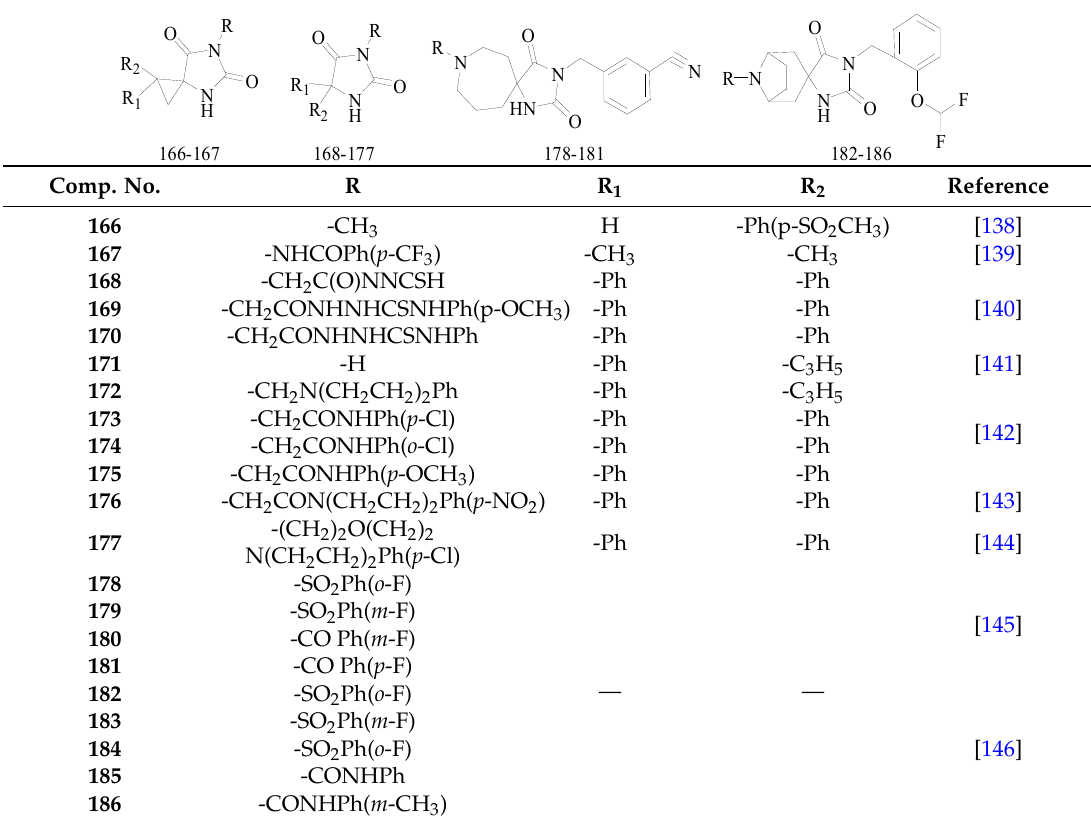
Table 8. Structures of compounds 166 – 186 .